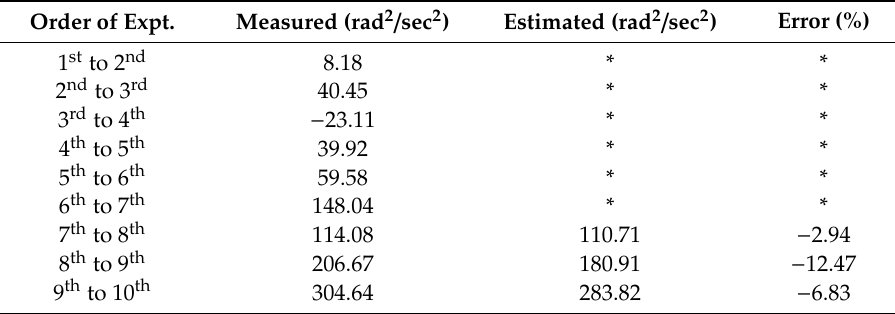
Table 3. List of ∆ ω 2 n between successive experiments.